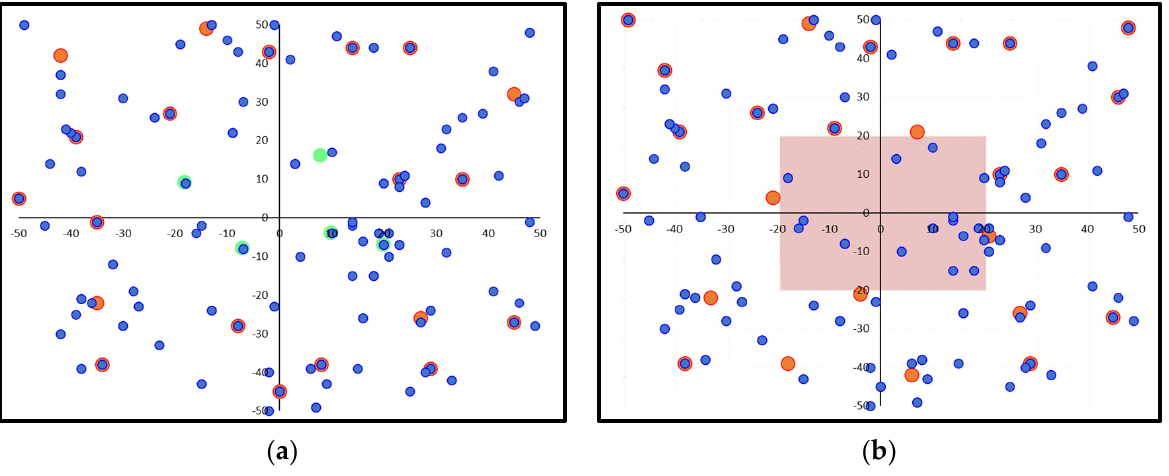
Figure 15. Indicative deployment optimization results of a 25-station network: ( a ) without infeasible zones; ( b ) with infeasible zones.